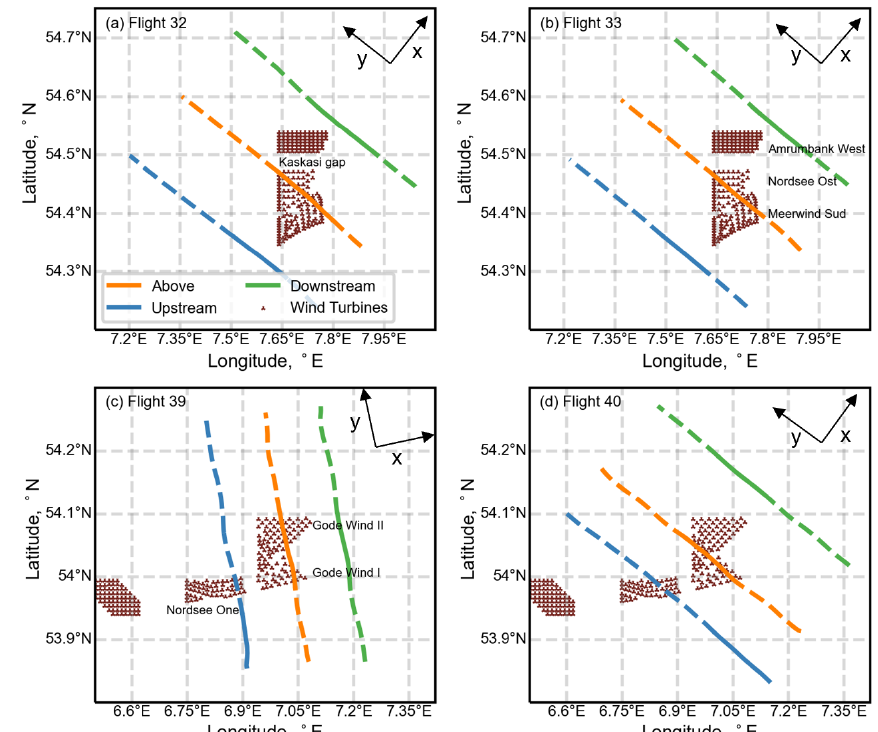
Figure 2. The four flights operated above two different wind farm clusters in the North Sea. (a) and (b) present the flight legs above Meerwind Süd and Nordsee Ost wind farms, (c) and (d) show the flight legs above Godewind 1 and 2 wind farms. The x – y axis presents the coordinate system in which geographical wind vectors are rotated, where x is the mean wind direction and y is the transverse direction in which flight measurements were recorded. The portion of the flight legs represented by solid lines is chosen for the analysis presented in this